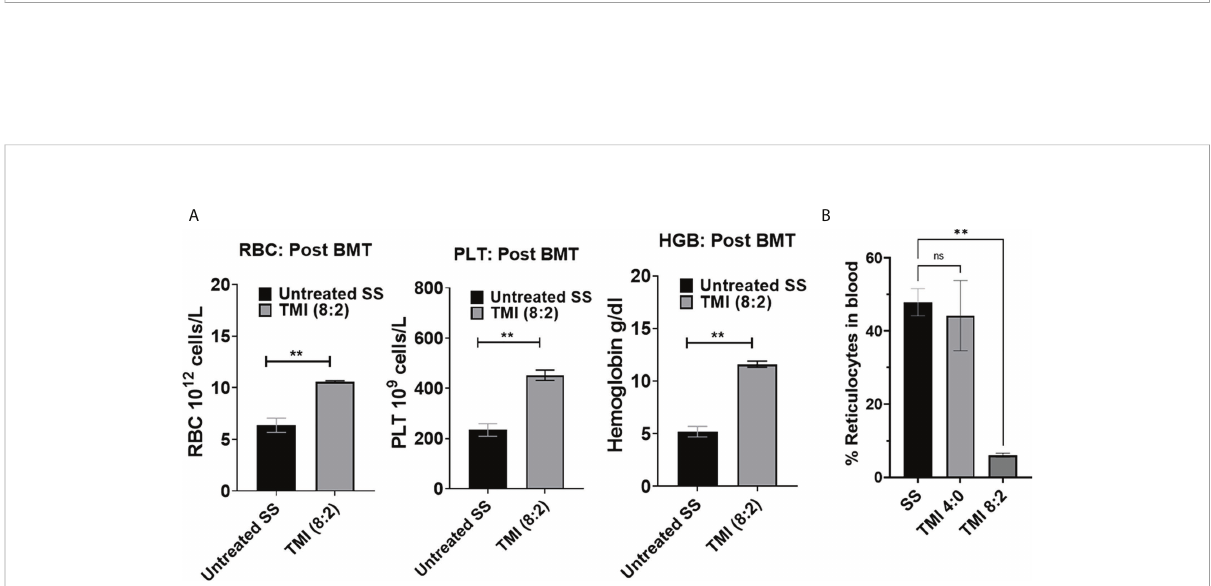
FIGURE 6 CBC analysis and peripheral blood reticulocytes from SS mice post-BMT. CBC was analyzed for TMI (8:2)-treated SS mice 90 days post-BMT. (A) RBC PLT and hemoglobin were signi fi cantly increased in BMT SS mice in comparison to untreated SS mice ( p = 0.0042, 0.0067, and 0.0012, respectively), suggesting recovery of SCD phenotypes by BMT. (B) The reticulocytes were also signi fi cantly reduced in SS mice post-BMT ( p = 0.0015) compared to untreated SS mice. Signi fi cance was determined using student's 't' test and 2 way ANOVA and was considered signi fi cant when p value was < 0.05. ns=non-signi fi cant, **p< 0.01.